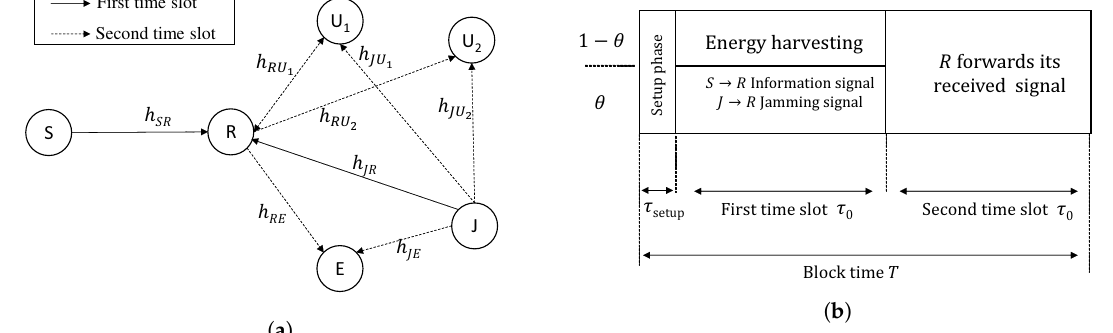
Figure 1. ( a ) The system model and ( b ) The power-splitting policy at R